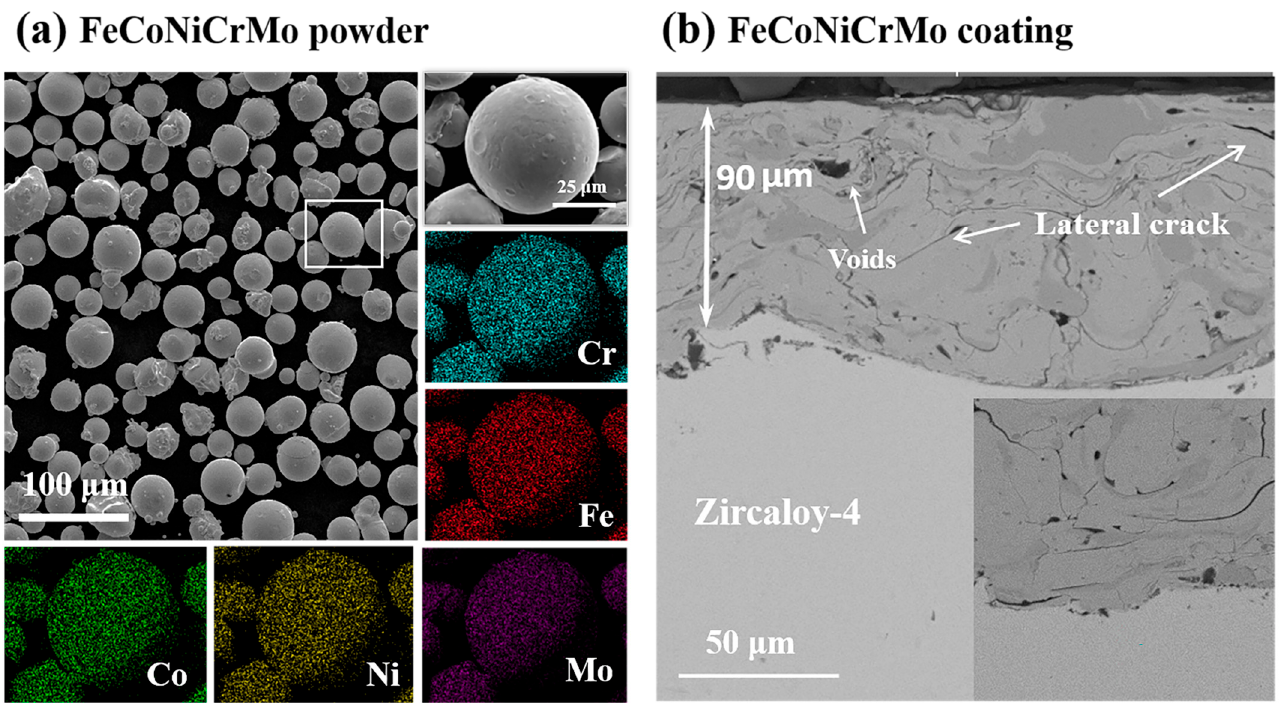
Figure 1. ( a ) SEM surface morphology of the FeCoNiCrMo powder; ( b ) cross ‐ section morphology of the FeCoNiCrMo coatings on the zircaloy ‐ 4 substrates.